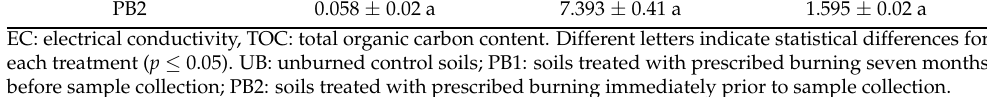
EC: electrical conductivity, TOC: total organic carbon content. Different letters indicate statistical differences for each treatment ( p ≤ 0.05). UB: unburned control soils; PB1: soils treated with prescribed burning seven months before sample collection; PB2: soils treated with prescribed burning immediately prior to sample collection.